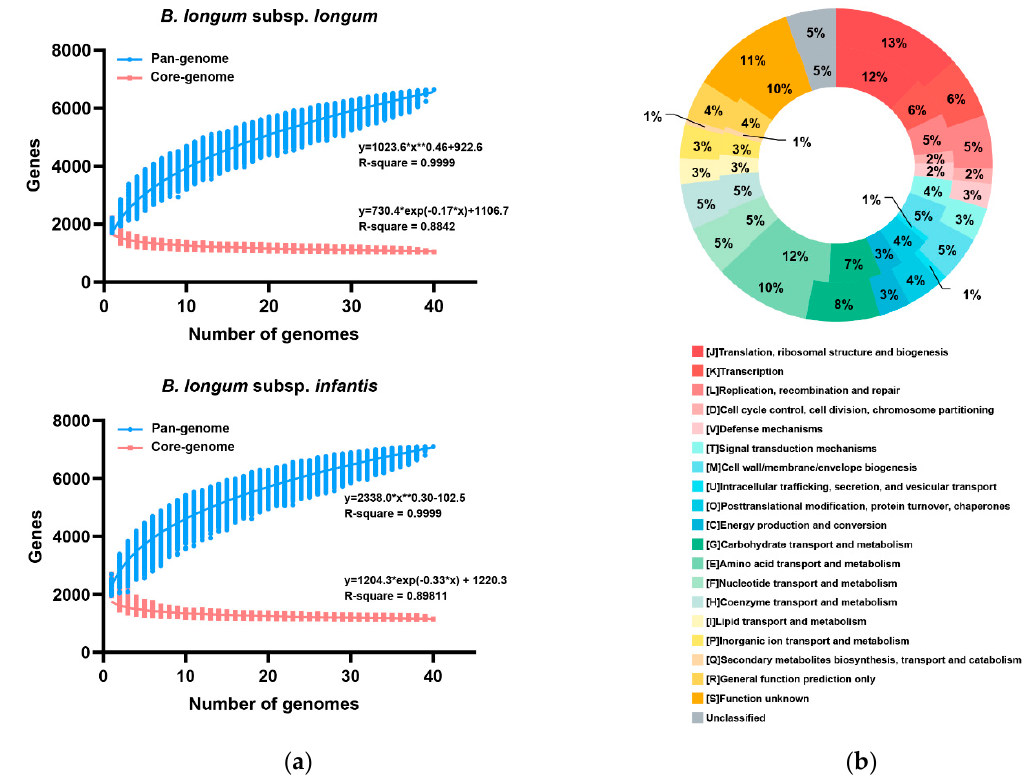
Figure 3. Pan-genome and core-genome of B. longum subsp. longum and B. longum subsp. infantis : ( a ) Numbers of pan-genes (blue) and core-genes (red) as a function of the number of genomes; * multiplication, ** exponentiation ( b ) Comparison of core gene function based on the COG database between B. longum subsp. longum (outside ring) and B. longum subsp. infantis (inside ring).